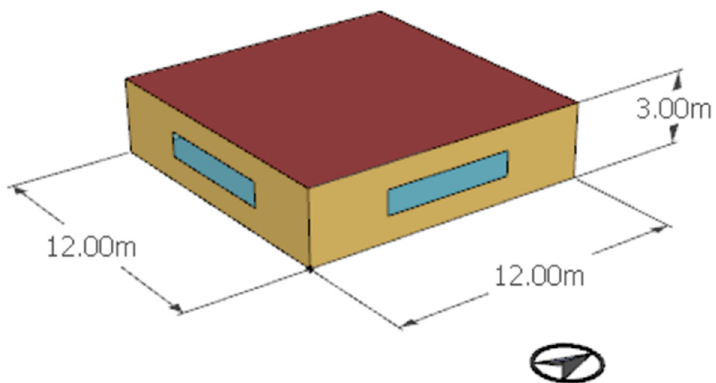
Figure 3. Three-dimensional (3D) rendering of the residential building model. Table 1. Main characteristics of baseline residential building energy model.